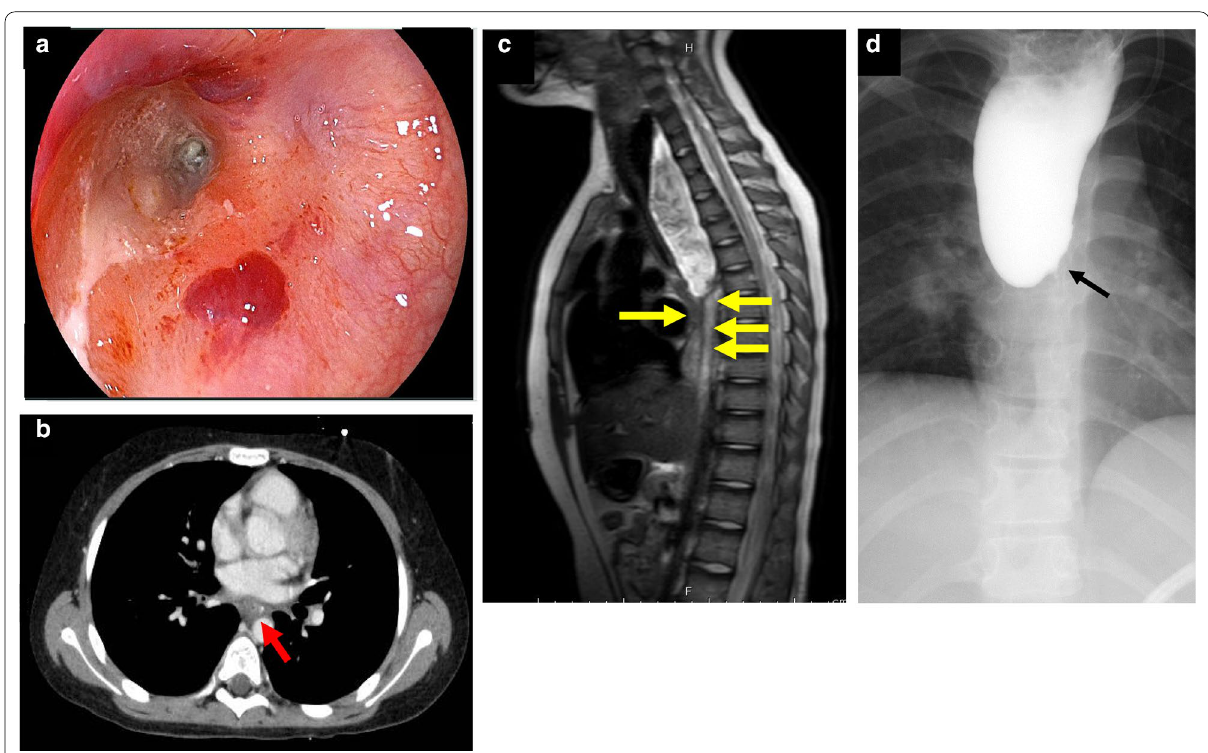
Fig. 4 Imaging findings. a Esophagoscopy revealing a severe stricture along with circumferential wall thickening, which made the passage of the scope impossible. b Contrast-enhanced chest computed tomography during chemotherapy revealing reduced lymphadenopathy in the mediastinal lymph nodes (red arrow). c Contrast-enhanced magnetic resonance imaging during chemotherapy revealing the narrowing of the middle thoracic esophagus (yellow arrows). d Barium contrast imaging revealing a complete obstruction (black arrow) in the middle